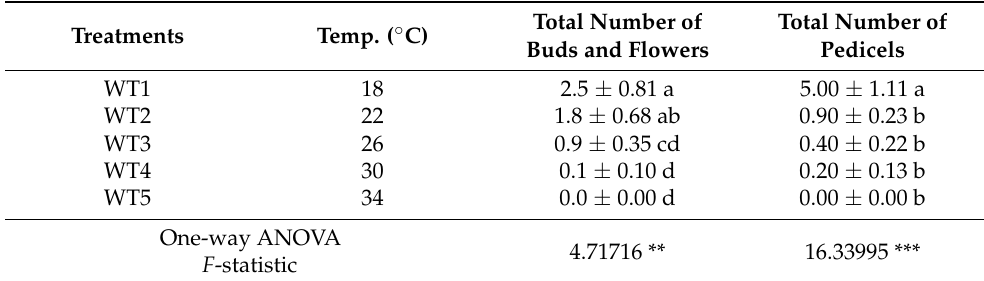
Table 3. The effect of various root zone water temperatures on the total flower development of S. formosus.